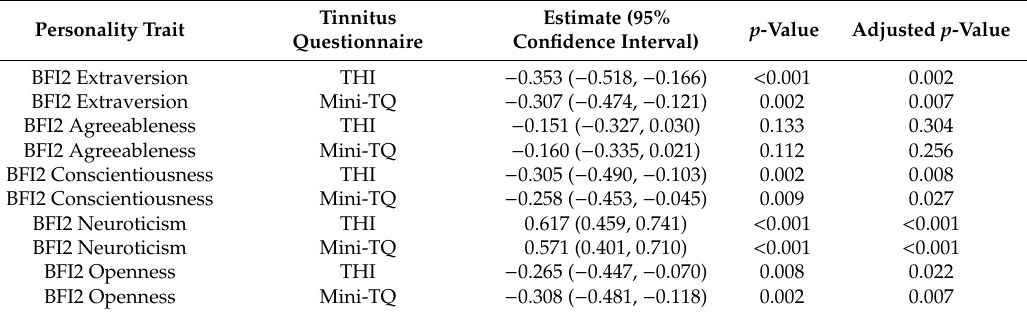
Table 4. Correlation analysis between tinnitus changes and personality traits during the pandemic. Tinnitus changes have been calculated by subtracting the value of the second time point (pandemic) from the first time point (baseline), meaning that positive change values indicate an increase of tinnitus-related distress.